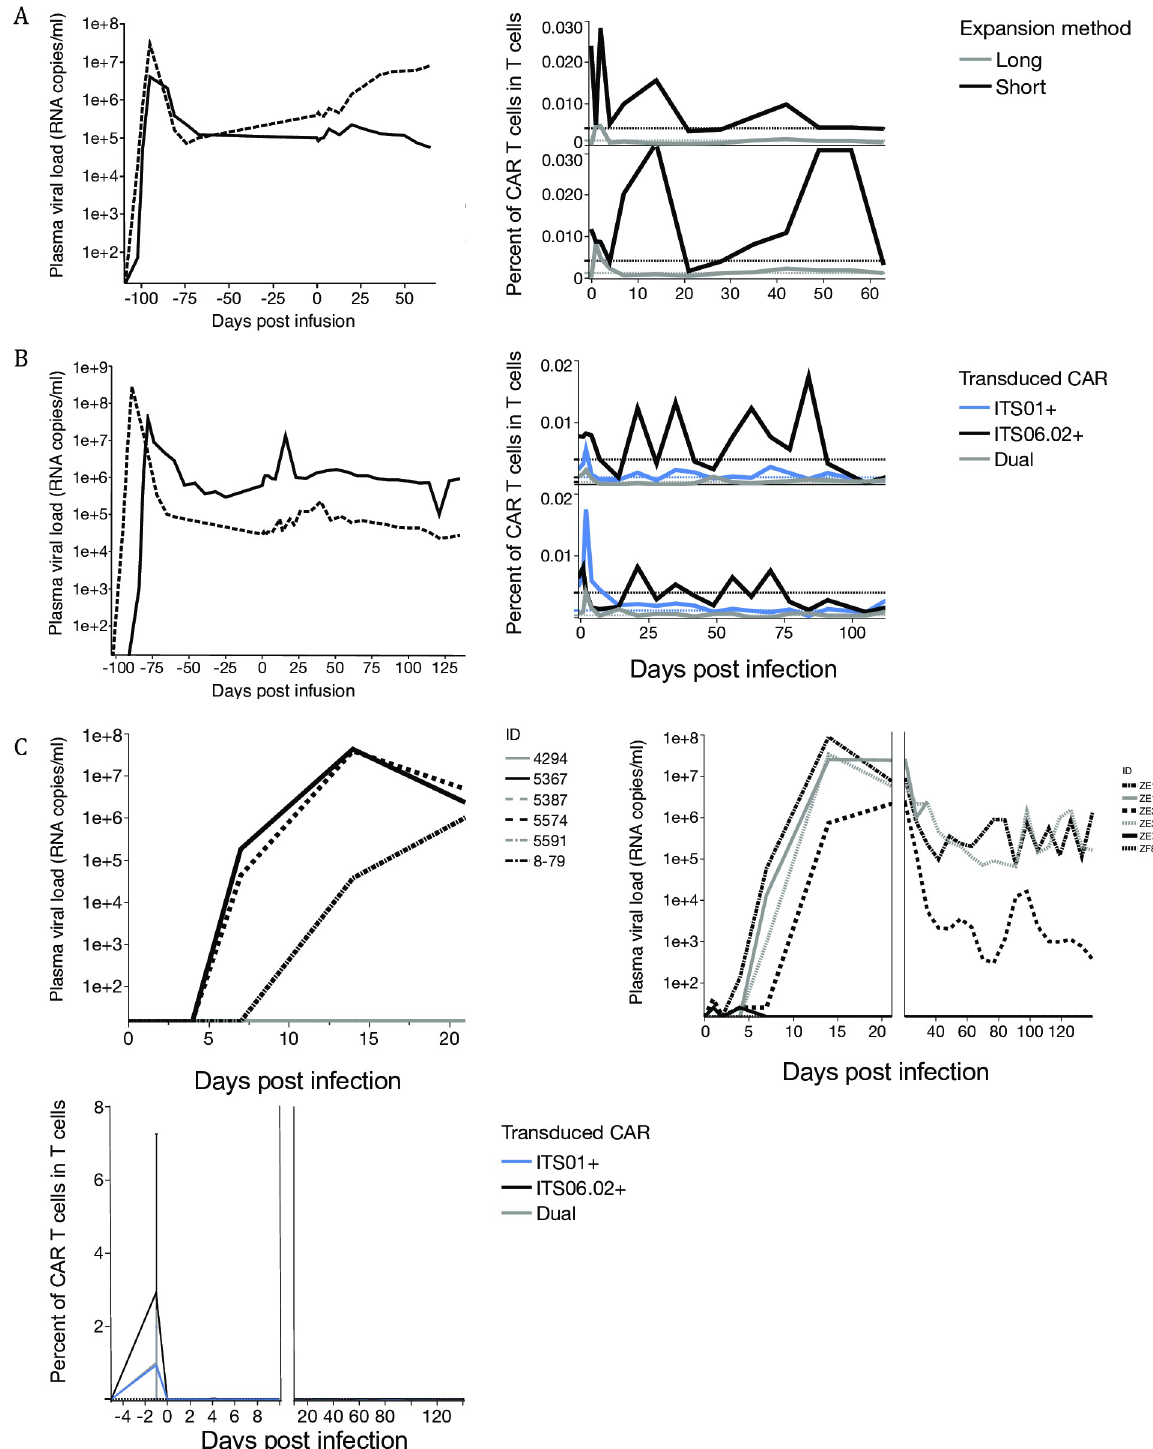
Fig 6. In vivo persistence of anti-SIV-CAR T cells and impact on plasma viral loads. (A)Plasma viral load and long- and short-term expanded SIV-CAR T cell persistence in chronically SIV-infected rhesus macaques. Left graph shows plasma viral loads before and after SIV-CAR T cell infusion. Right graph shows frequency of SIV-CAR T cells in T cells in PBMC. Black lines show frequencies of short-term expanded SIV-CAR T cells and grey lines show those of long-term expanded SIV-CAR T cells. Dashed lines show background level of reporter gene expression in SIV-CAR negative rhesus macaques. (B) Plasma viral loads and SIV-CAR T cell in chronically SIV-infected rhesus macaques. Left graph shows